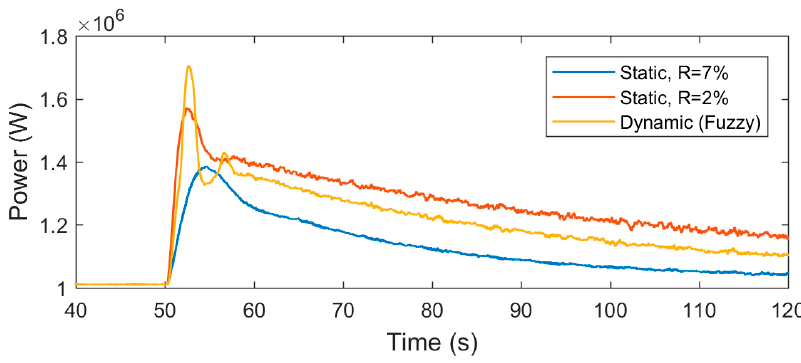
Figure 11. Wind turbine power (large ROCOF).